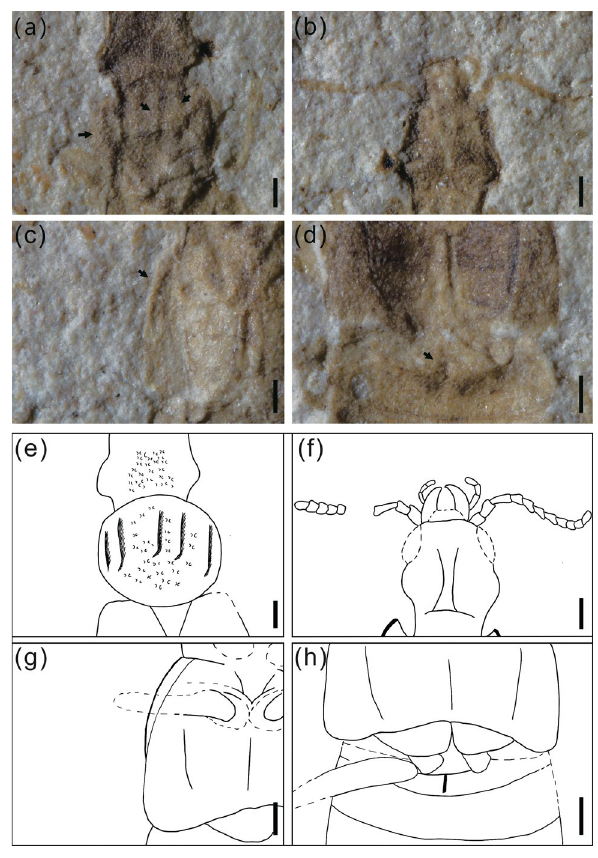
Figure 3. Morphological details of Cretaceonanobius fossilis gen. et sp. nov. (holotype, NIGP 177043). ( a ) pronotum of the part (arrows, carina on the pronotum); ( b ) head, ventral; ( c ) left elytron (arrow, hypomeron); ( d ) base of abdomen (arrow, intermetacoxal carina); ( e ) same as ( a ), line drawing; ( f ) same as ( b ), line drawing; ( g ) same as ( c ), line drawing; ( h ) same as ( d ), line drawing. Scale bars = 200